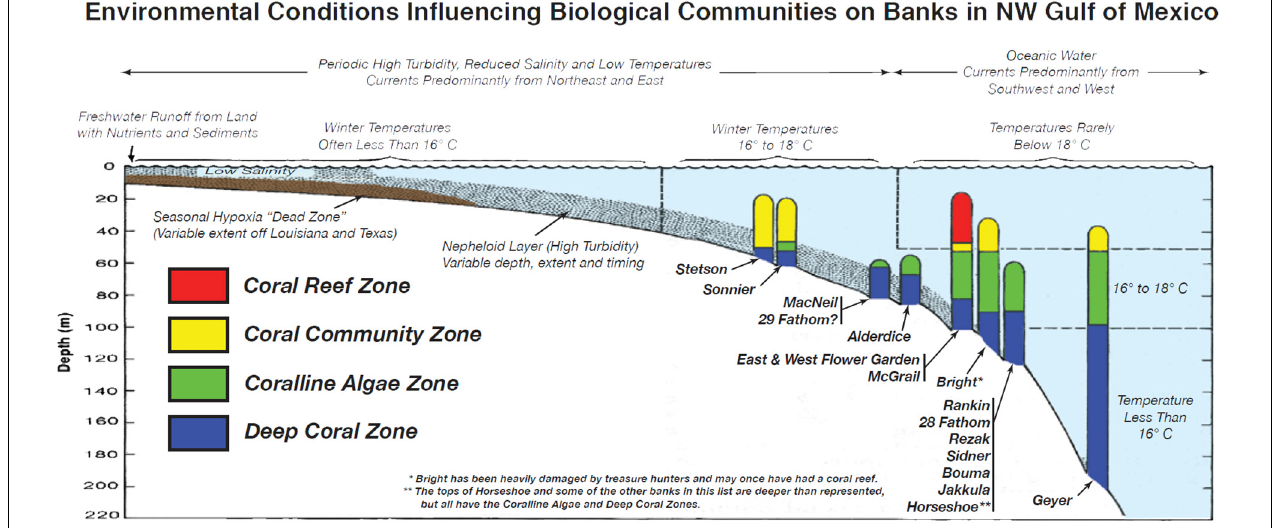
FIGURE 4 | Environmental controls on biological communities on NW Gulf of Mexico reefs and banks using data from Rezak et al. (1990), and Schmahl et al. (2008). Some of the zones of the mentioned banks have not been fully evaluated so this diagram is only a tool for predicting the distribution of the various community zones. Evaluating how changes in the factors that control these communities will be an important basis for assessing climate impacts, and developing management responses as possible changes in the distribution, and composition of biological communities on the banks occur.